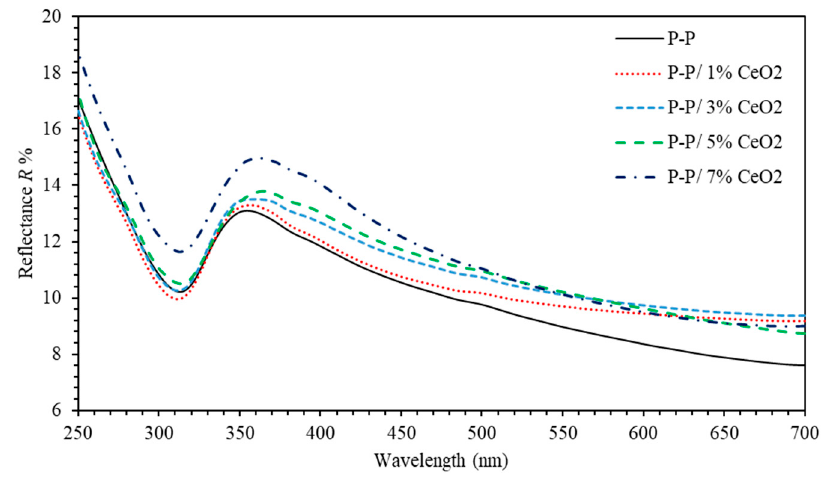
Figure 2. The reflectance of (PMMA-PS)/CeO 2 nanocomposite thin films with various CeO 2 NPs concentrations.